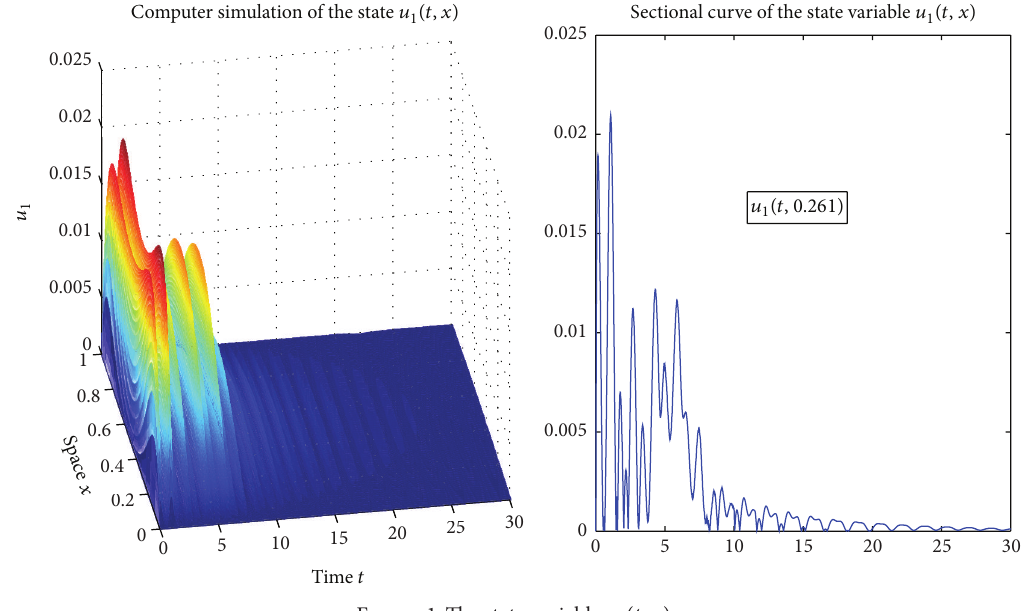
Figure 1: The state variable 𝑢 1 (𝑡,𝑥)